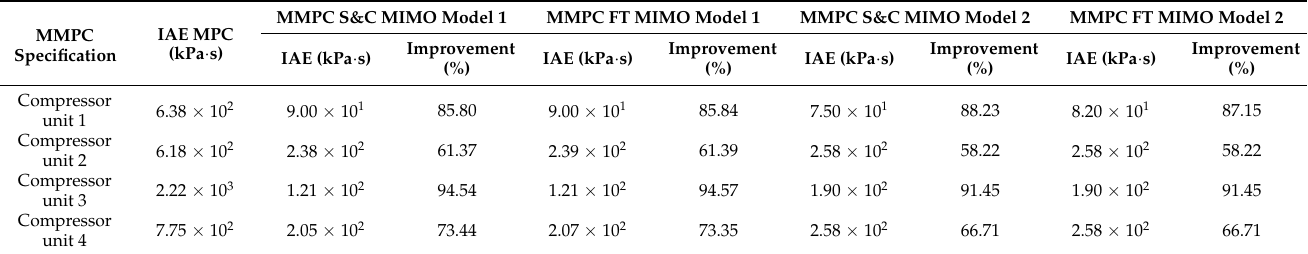
Table 17. MMPC performance (IAE) and performance improvement in the compressor unit.